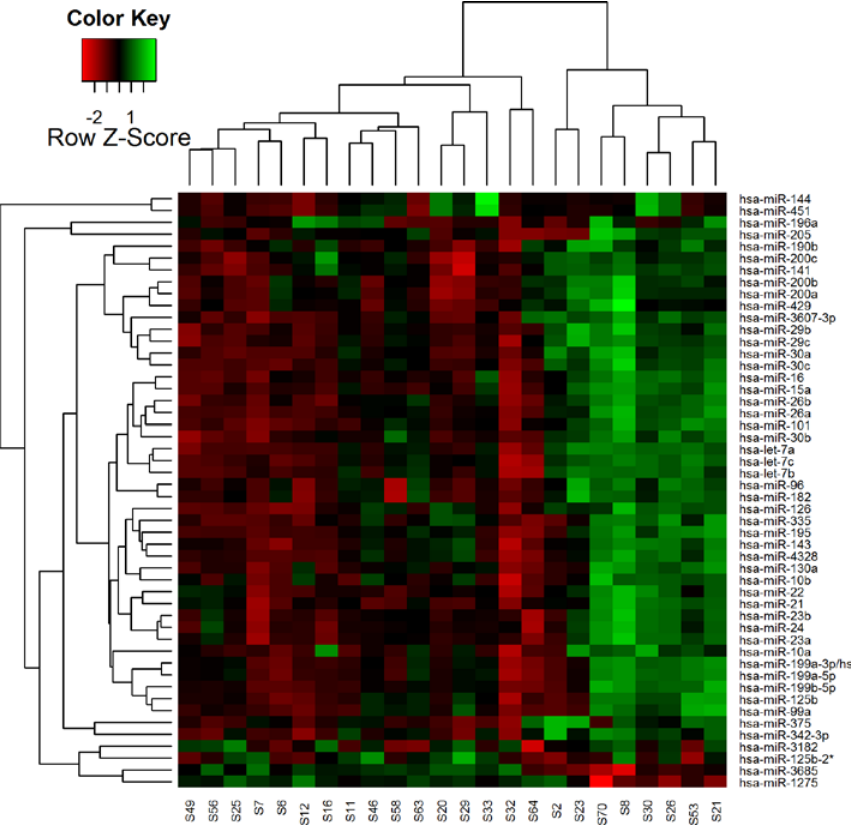
Fig 2. Heat map of unsupervised hierarchical clustering. Hierarchical clustering performed on all samples using the top 50 miRNAs showing the highest standard deviation across all samples.